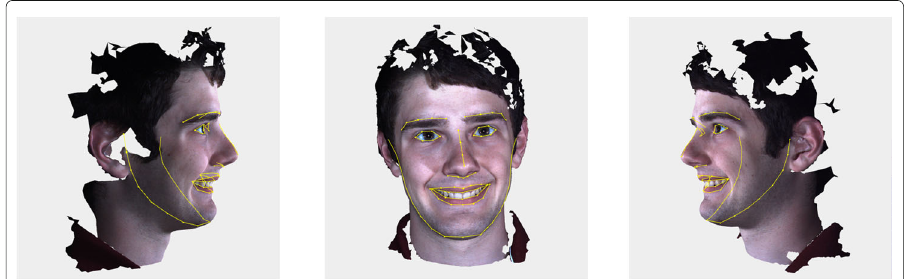
Fig. 6 3D ground-truth landmarking using